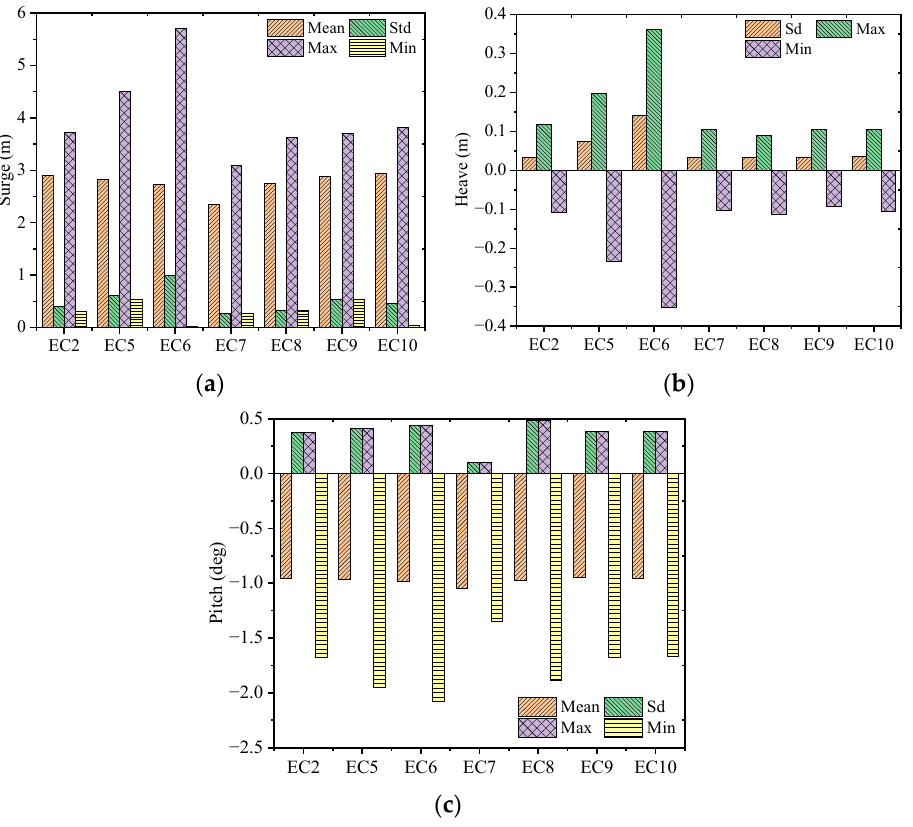
Figure 13. Statistics of platform motion response of ( a ) surge, ( b ) heave and ( c ) pitch. The RootMyc1 is crucial to the overall performance of the integrated LSBT-FOWT-AC system; thus, its statistical value is also of great significance to consider. It can be seen from Figure 14 that the mean value of RootMyc1 fluctuates marginally in these seven ECs, except for the case of EC7 where a smaller mean value of14,400 kN · m is observed, while all the others fluctuate around 17,000 kN · m. Therefore, the wave height has little effect on the mean value of the RootMyc1, whereas the Max and Min values vary significantly with wave height. It is also observed that the Max and Min values of the RootMyc1 appear in the case of EC8 with the largest wind speed, which are 59,600 kN · m and − 27,900 kN · m, respectively. Hence, the influence of wind speed on the RootMyc1 is significant, and the four statistical values all increase with the increase in wind speed. However, the variation of current speed has no effect on the RootMyc1. In general, the RootMyc1 is not sensitive to the change of wave height and current speed, which is mainly affected by the